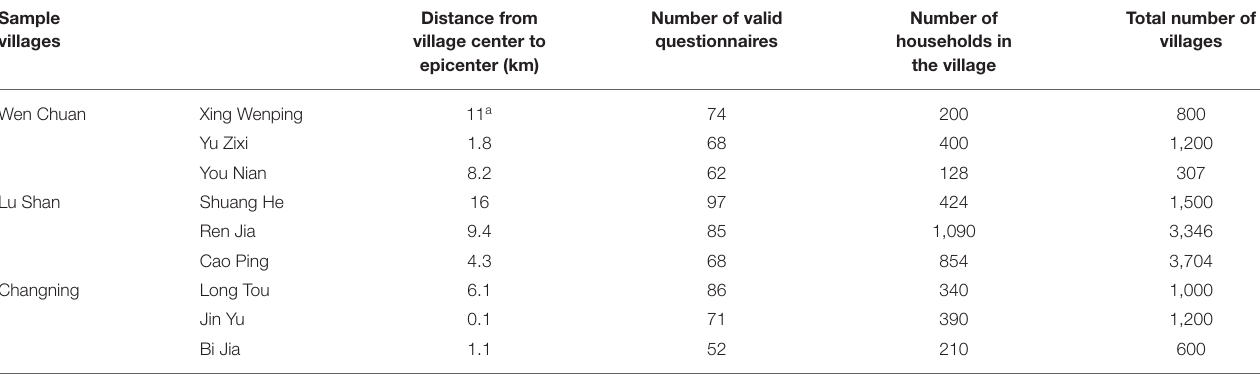
TABLE 1 | Distance to epicenter and number of valid questionnaires. Sample